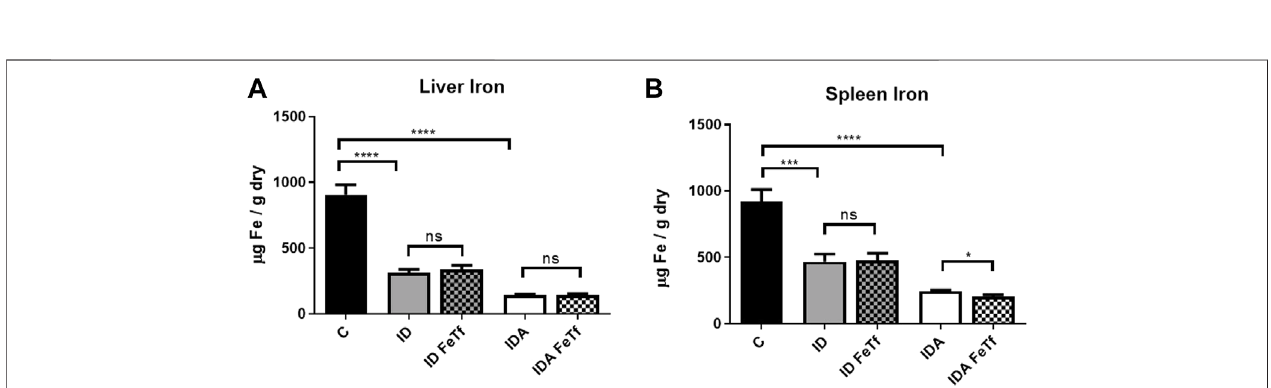
FIGURE3| Tissueiron progressively decreases withseverityofiron restrictionin mice withID and IDA. IDand IDA mice weretreatedwith carrier or holotransferrin. (A) Liver iron concentrations and (B) spleen iron concentrations were measured. Control mice fed a standard 250 ppm Fe diet are included for reference. For control mice, n = 5-6, for ID cohorts n = 15 – 20 and for IDA cohorts n = 5-7 mice per group. ppm, parts per million; data represented as mean (SEM).*, p < 0.05; ***, p < 0.005; ****, p < 0.001; ns, non-signi fi cant.